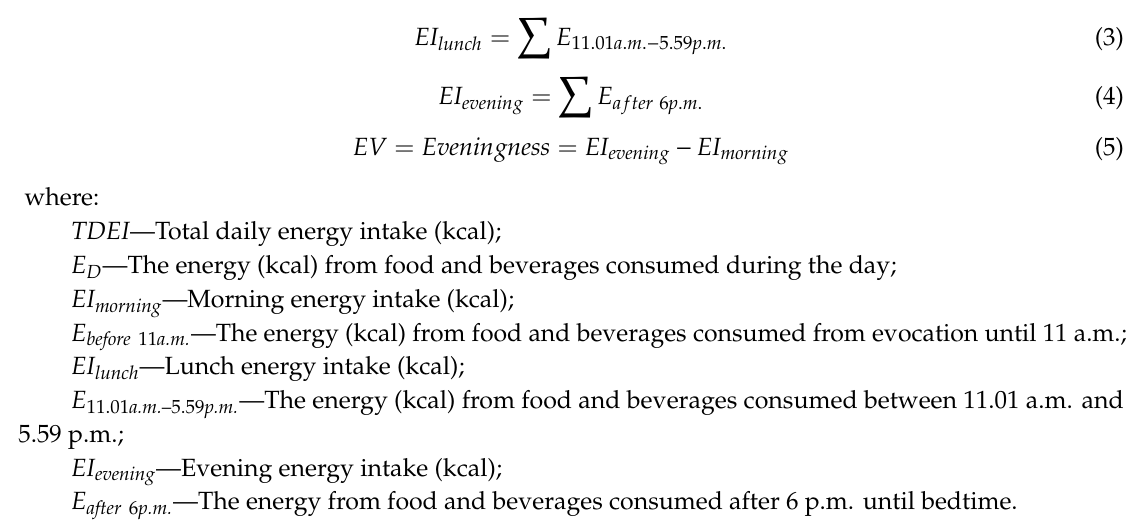
Table 2. Age and gender-specific BMI cut-o ff points depending on the nutritional status of adolescents [22].